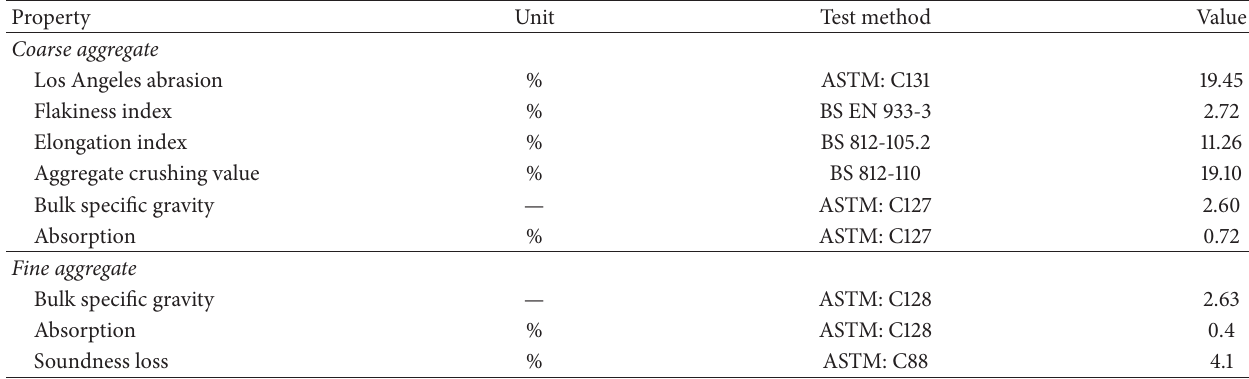
Table 1: Properties of crushed granite aggregate used in this study.